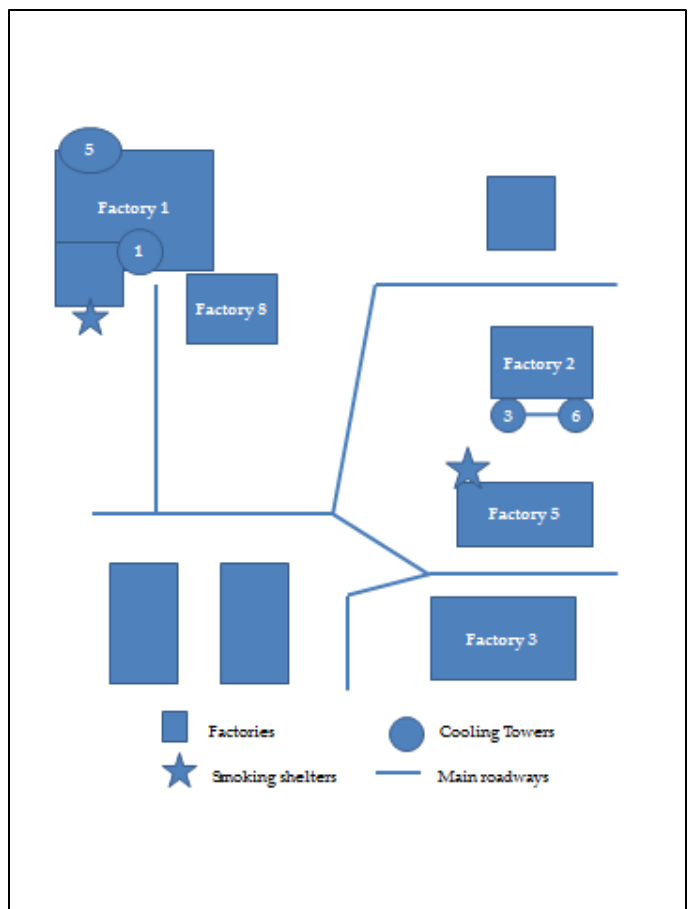
Figure 1. Layout of factory complex showing cooling towers (CTs), smoking shelters, and main roadways.